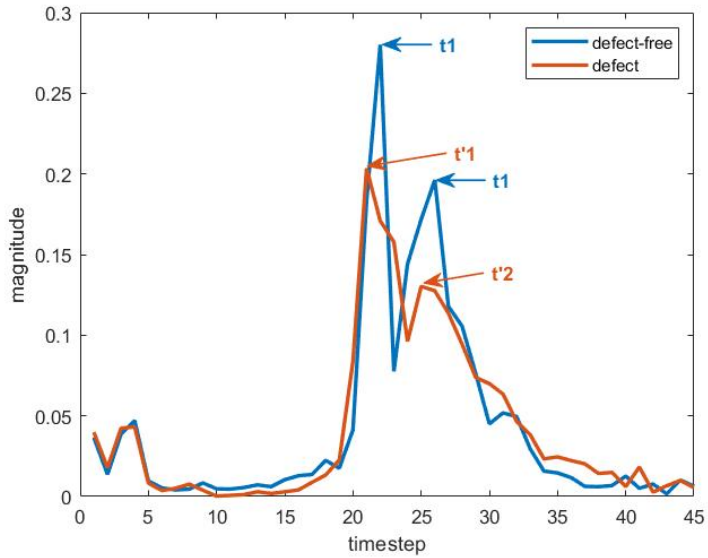
Figure 10. The peak of magnitude dispersion of delamination, t’ 1 and t’ 2 and delamination-free signals, t 1 and t 2 within the initial 45 time steps.